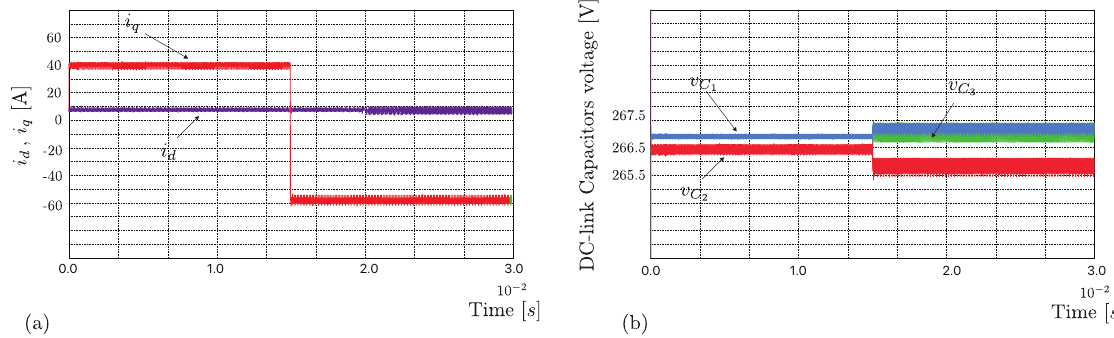
Figure 8. Simulation results for current reference step inversion using classical Field Oriented Control strategy with LS-PWM: ( a ) d q stator currents, ( b ) dc-link capacitor